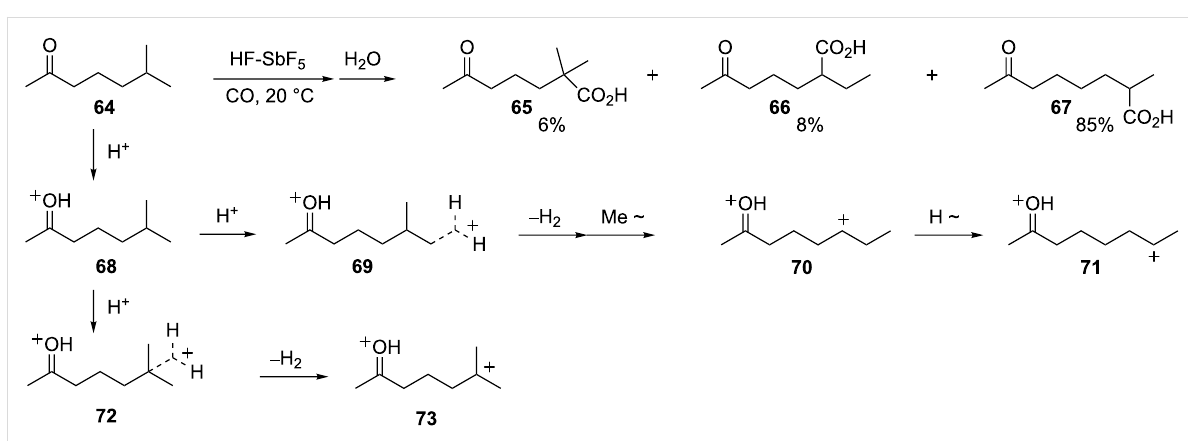
Scheme 14: Reaction of dialkylketone 64